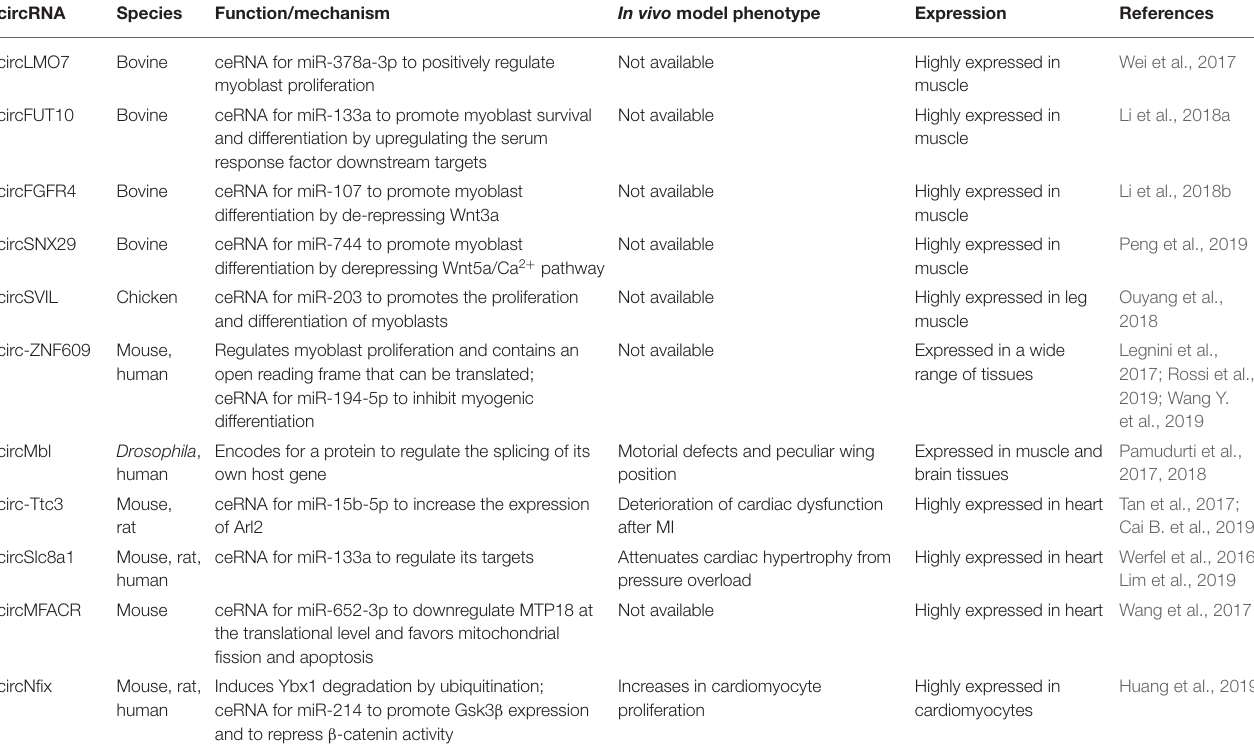
TABLE 4 | Circular RNAs (circRNAs) in skeletal and cardiac